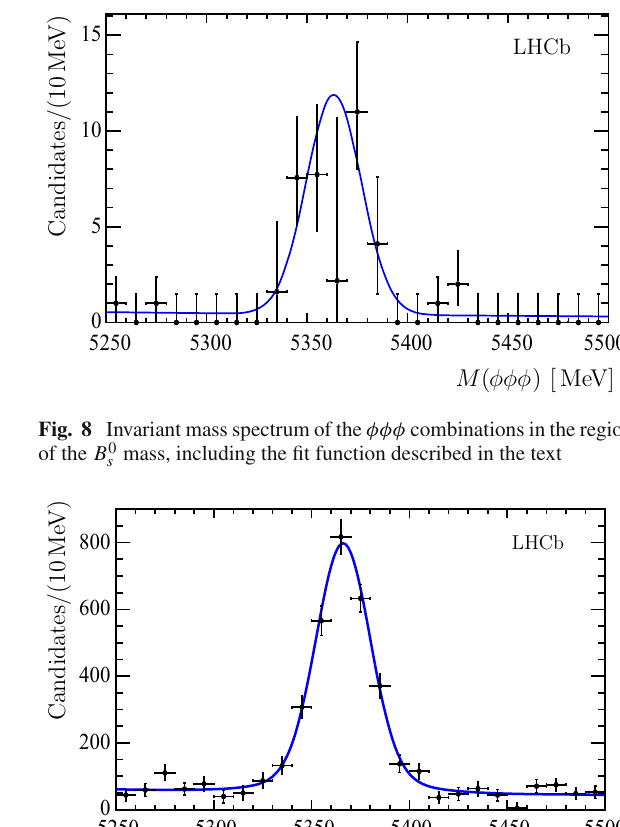
/ε = B 0 s → φφφ B 0 s → φφ